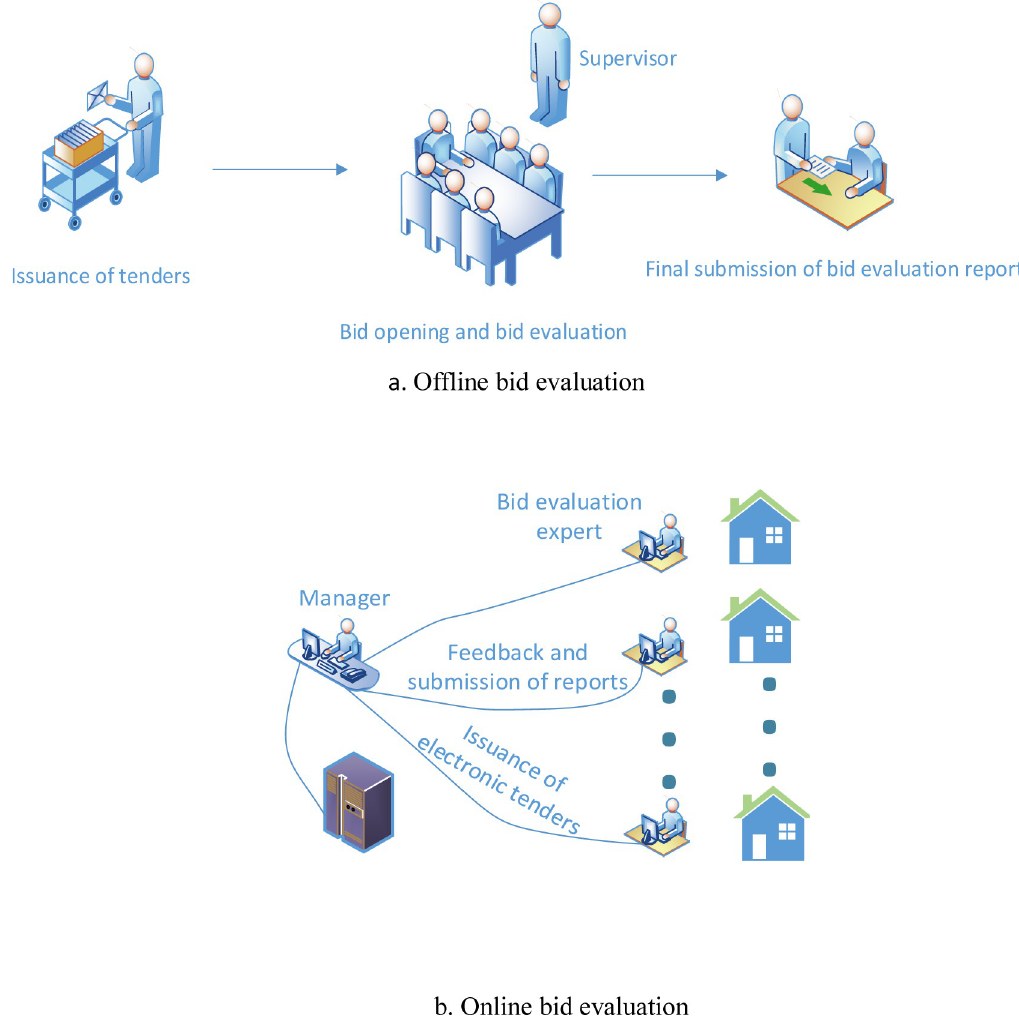
Fig 1. Two bid evaluation mechanisms. a. Offline bid evaluation. b. Online bid